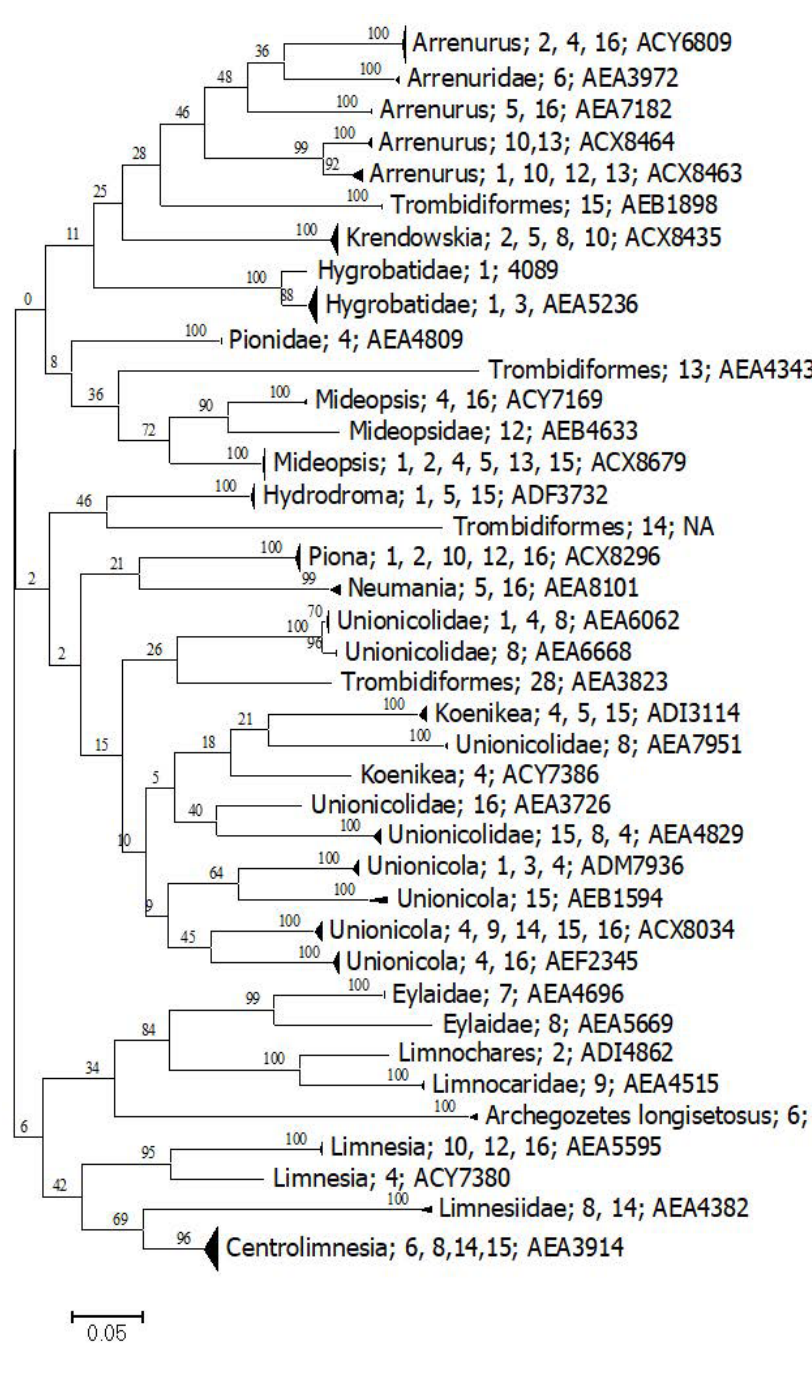
Figure 3. Simplified ID tree for Arachnida represented in the samples. All of them belong to Trombidiformes. Some of the sequences presented here are public [43]. Numbers represent the aquatic system, as presented in Table 1. The last number corresponds to the BIN assigned in BOLD. Support bootstrap values are on each branch.